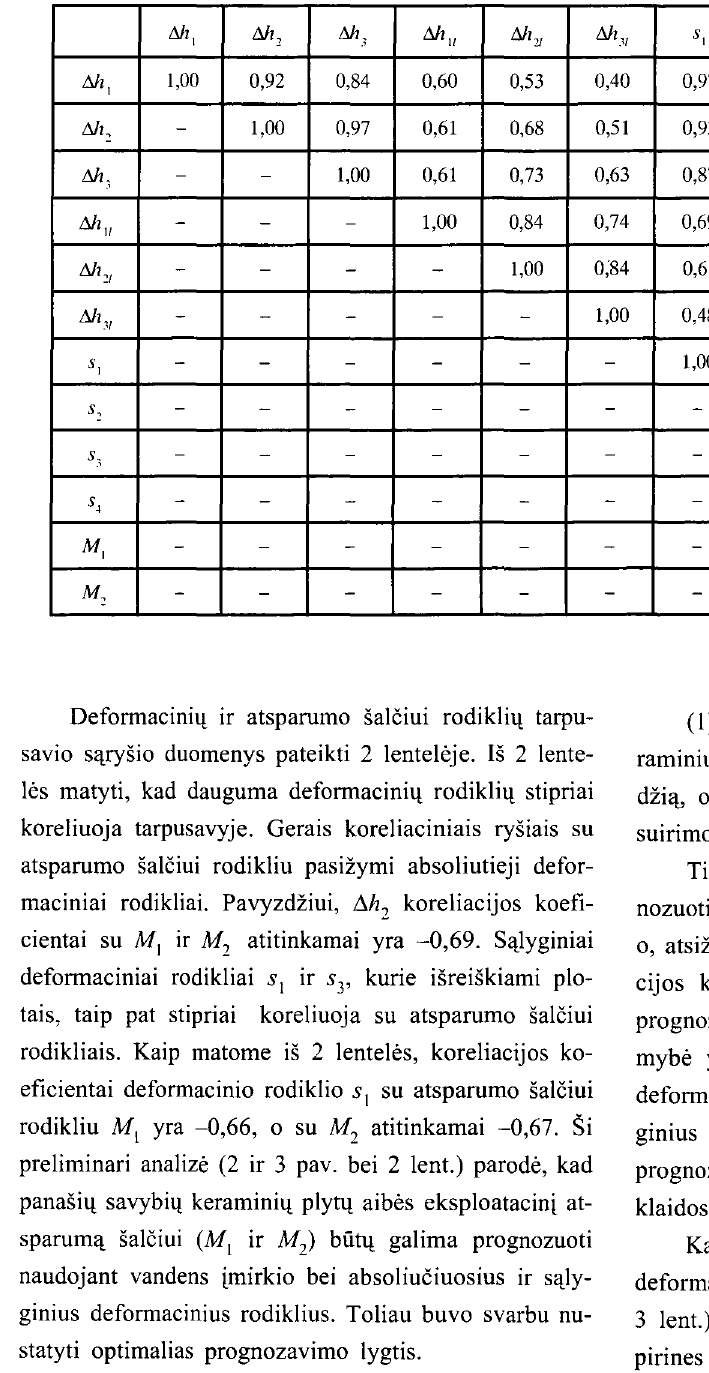
Table 2. Correlation coefficients matrix of deformational and frost resistance factors of ceramic specimens Ml D.h, M, tJ.h II !!.h?J D.hl